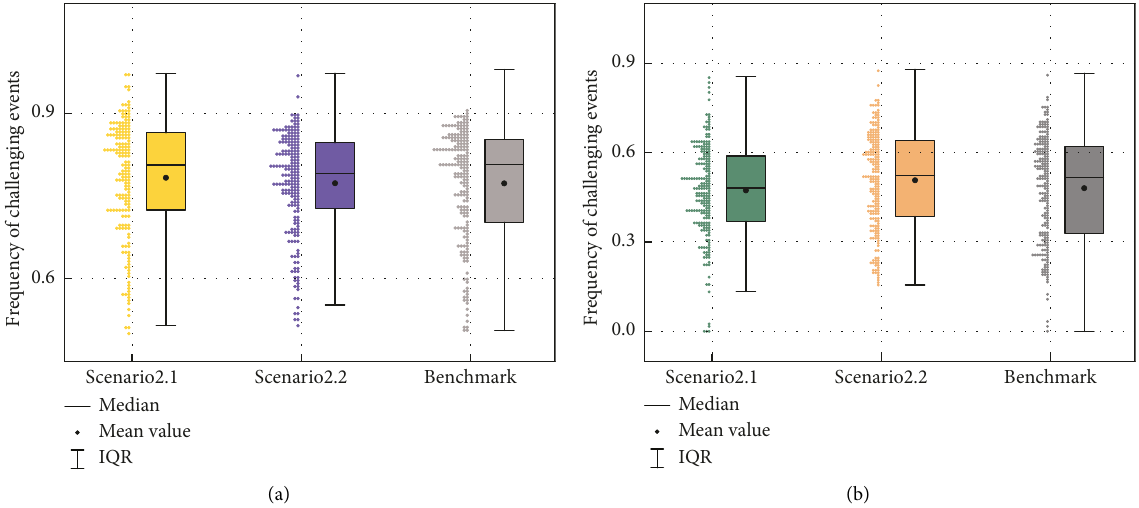
Figure 11: The boxplots for the second simulation: (a) the frequency of challenging events in each scenario when TTC is less than 2 s and (b) the frequency of the challenging events in each scenario when the headway is less than